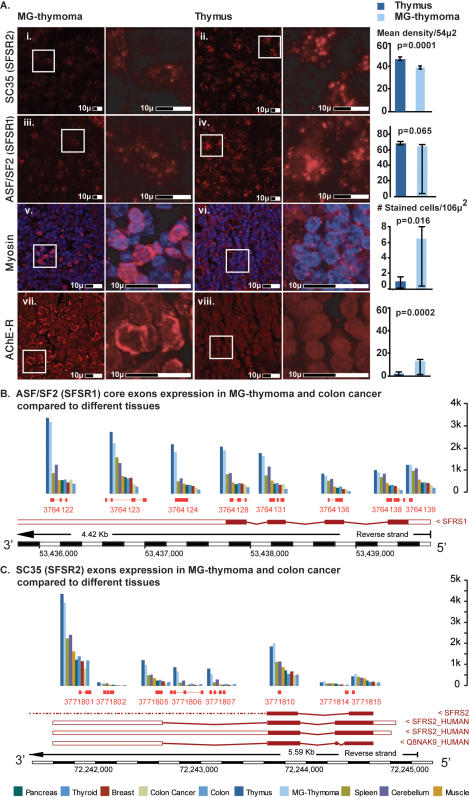
mRNA and protein expression of splicing factors ASF/SF2 and SC35, Myosin and ACHE.Immunohistochemistry indicated (A) Decrease in the mean density of the splicing factors: SR protein ASF/SF2 between MG-thymoma (i) to healthy thymus (ii) (p = 0.065) and SC35 between MG-thymoma (iii) to healthy thymus (iv) (p = 0.0001). The number of myosin expressing cells increased (p = 0.016) in MG-thymoma (v) compared to healthy thymuses (vi). (C) FISH for AChE-R variant indicated a significant increase in the number of stained cells in the MG-thymomic section (vii) compared to healthy thymus (viii) (p = 0.0002). (B) Exonic expression maps of ASF/SF2. All the core exons are shown. MG-thymoma (light blue) exhibited a decrease compared to healthy thymus (dark blue) in both ASF/SF2 (B) and SC35 (C). The expression level in both healthy and cancer thymus were higher then in other tested tissues for both (B and C). The known transcript variant of ASF/SF2 is expressed (C). SC35 exhibits expression of two transcript variants in MG-thymoma compared to thymus samples: one containing exons 1 and 2 alone, and one containing an additional 3′ exon.